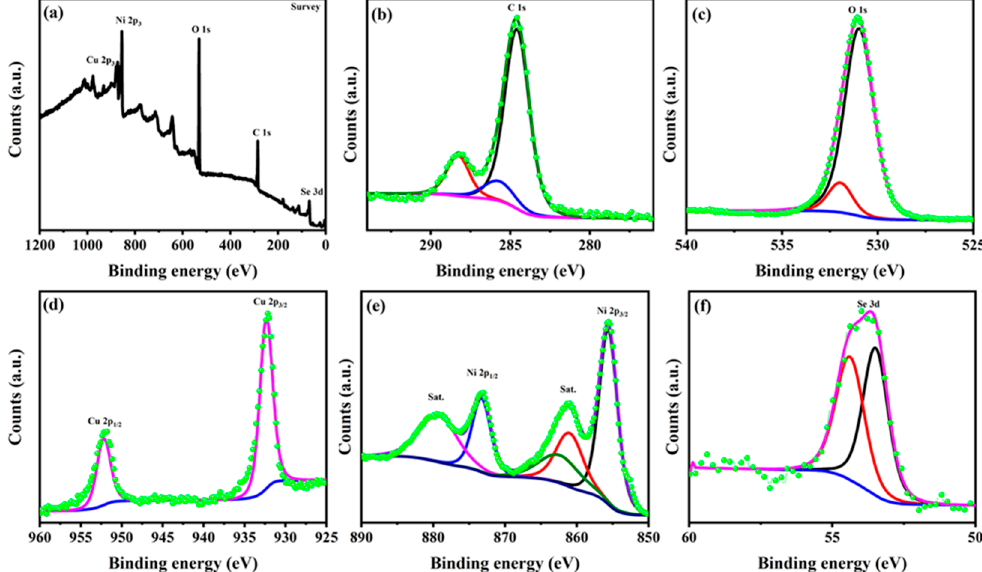
Figure 3. XPS of sample S-4. ( a ) Survey spectrum. Core levels of ( b ) C1s, ( c ) O1s, ( d ) Cu2p, ( e ) Ni2p, and ( f ) Se3d.